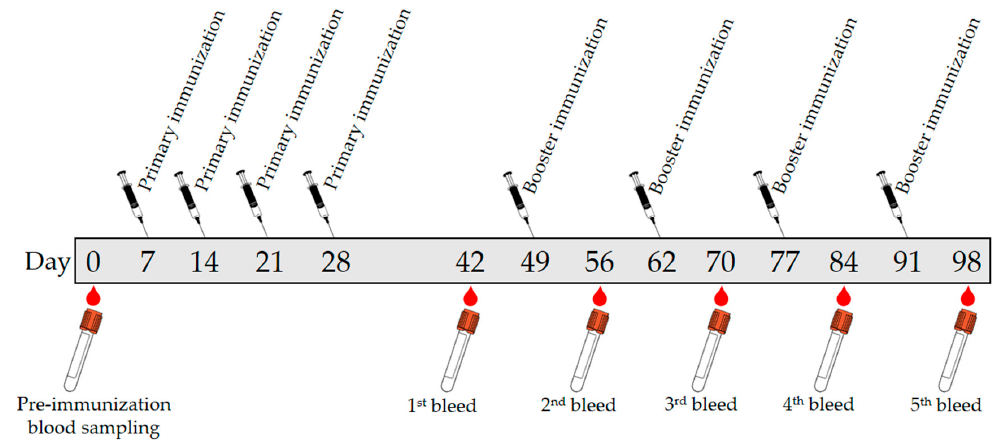
Figure 7. A schematic representative of immunization protocol and blood samplings.